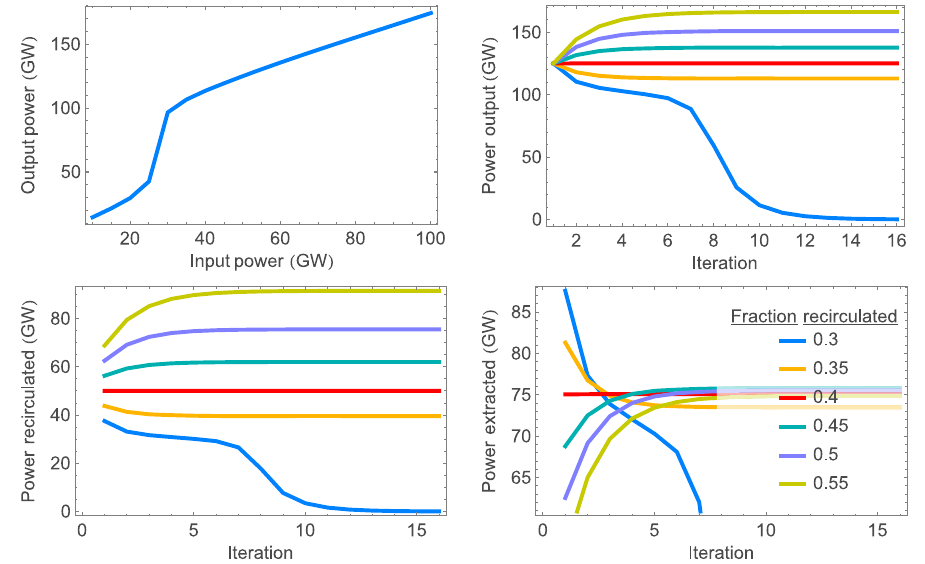
FIG. 9. Input-output power map (top left) is used to estimate oscillator performance for 50 GW startup power various power recirculation fractions.